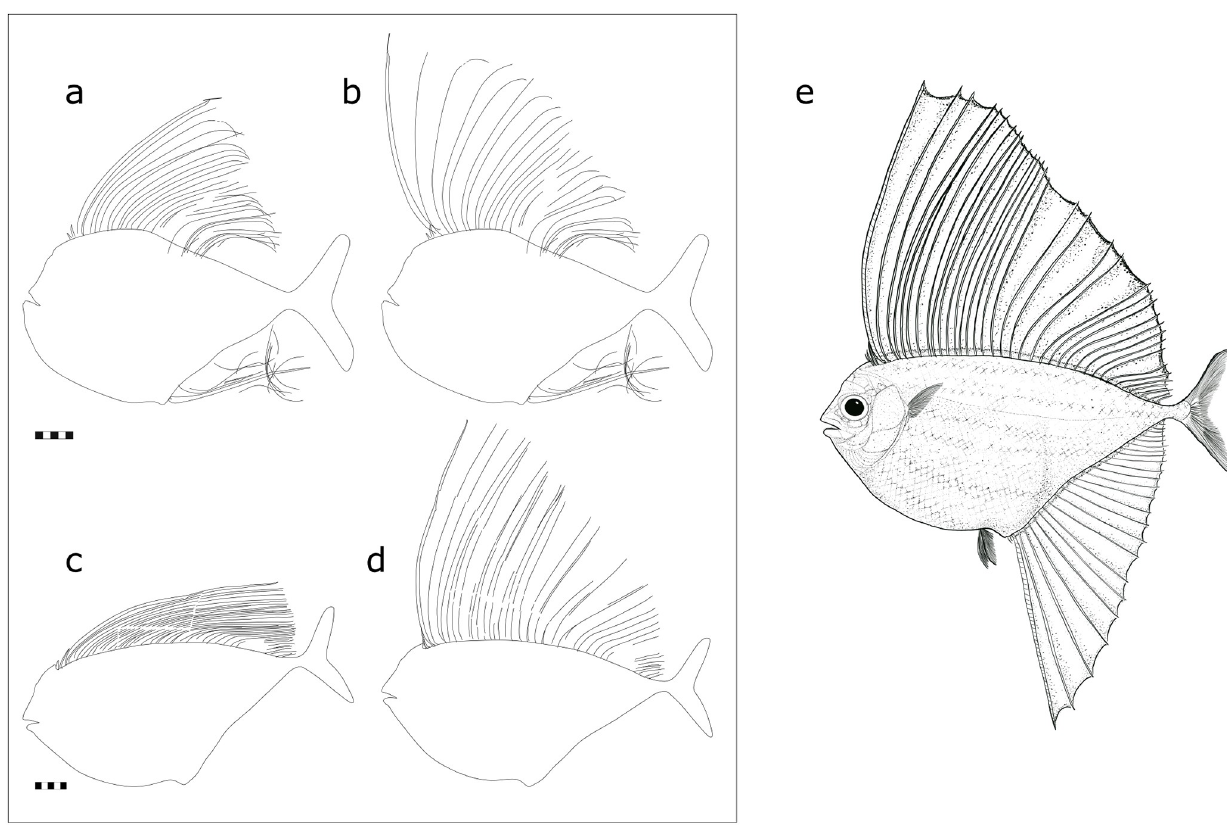
Fig 11. Reconstruction of the dorsal fin of T . formosa . Fossil outline as identified in CPC-2839 and CPC-2948; REG2544 PF48 with semi-erected dorsal fin (A and C) in comparison to its modification (B and D) with erected dorsal fin. Schematic reconstruction of the dorsal and anal fin including a membrane between the fin rays (E) and scale color as suggested by Giersch (2014). Both scales 50